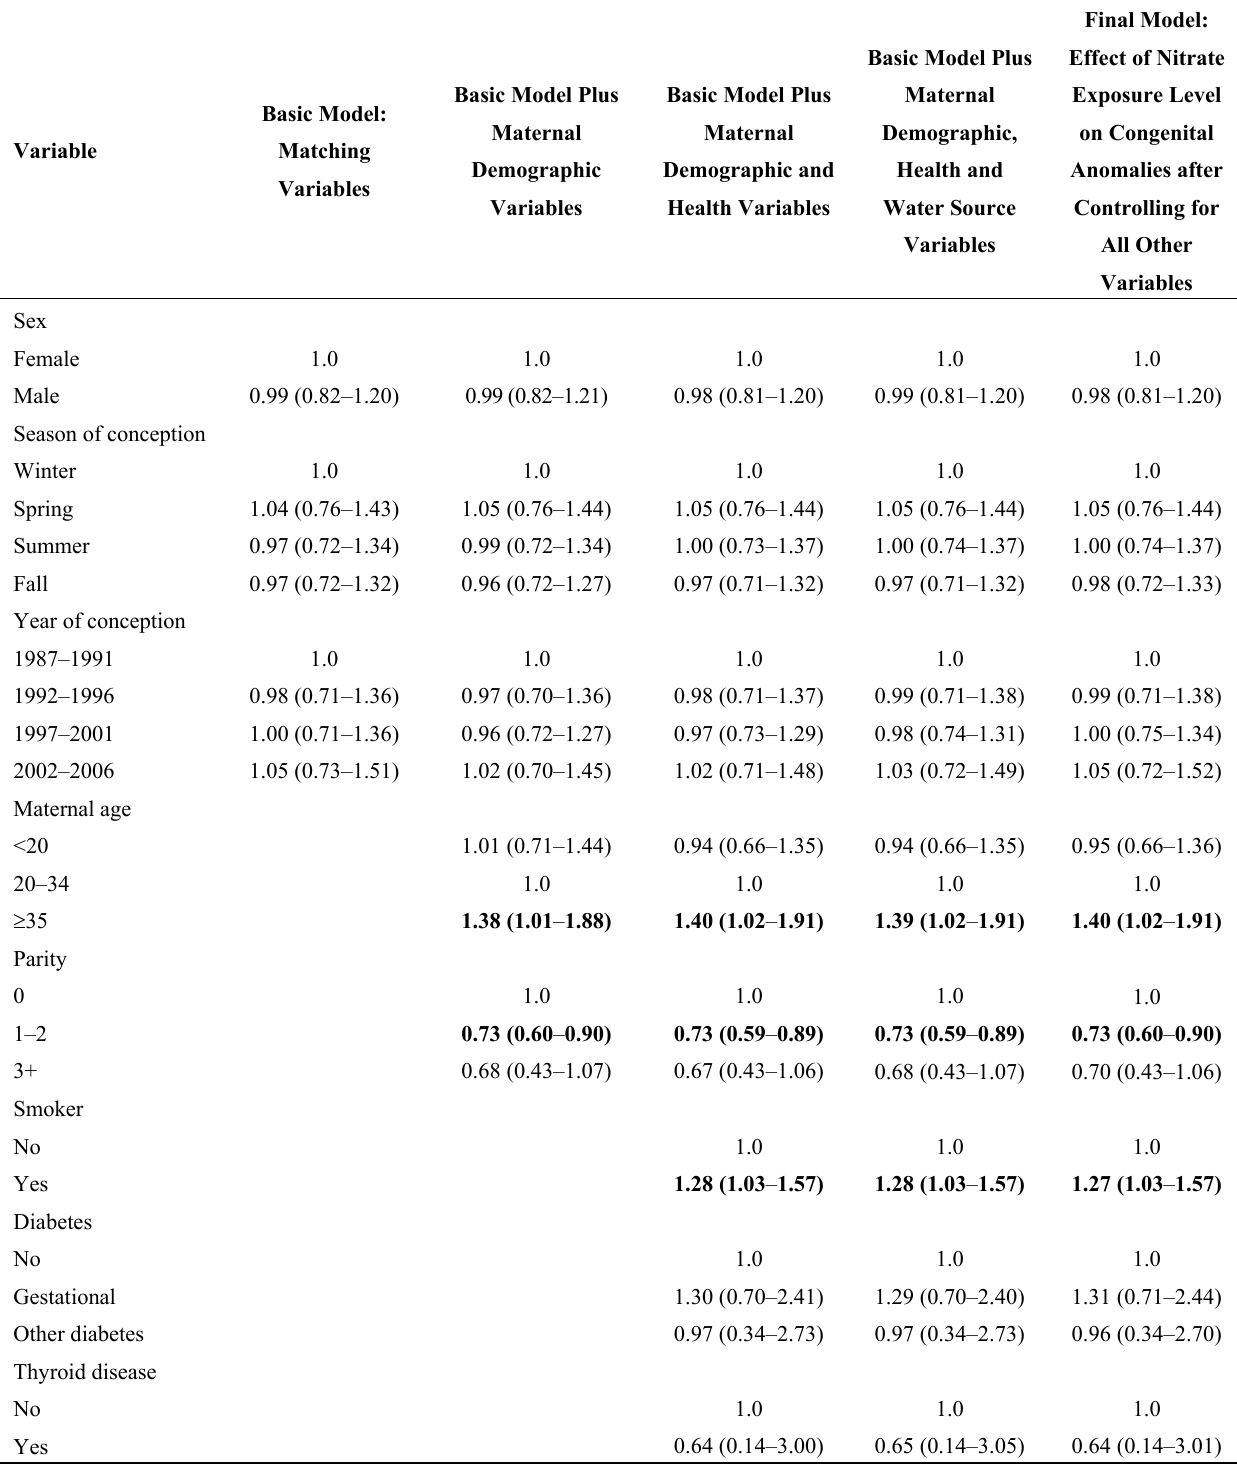
Table 4. The progressive generation of the final multivariable logistic regression model describing the incidence of congenital anomalies by nitrate exposure level in a stepwise fashion such that potential confounding variables are added to the model one group at a time for all data from